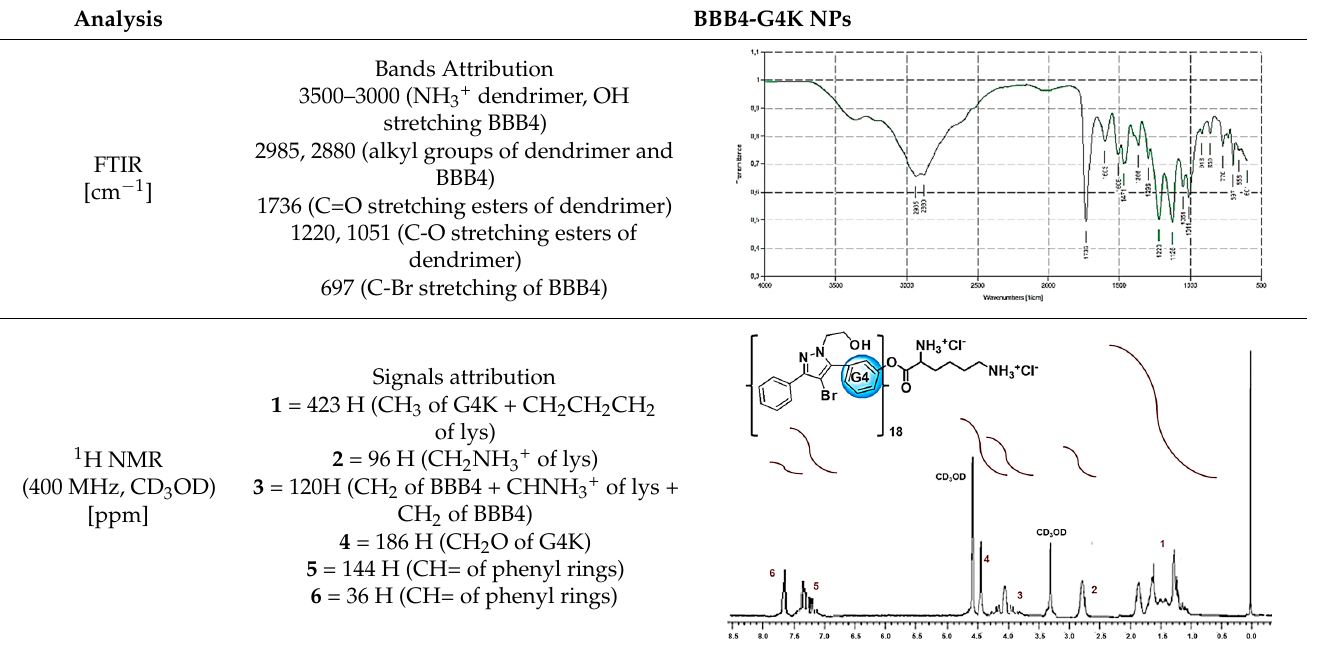
Table 1. Main characteristic of BBB4-G4K NPs [16].